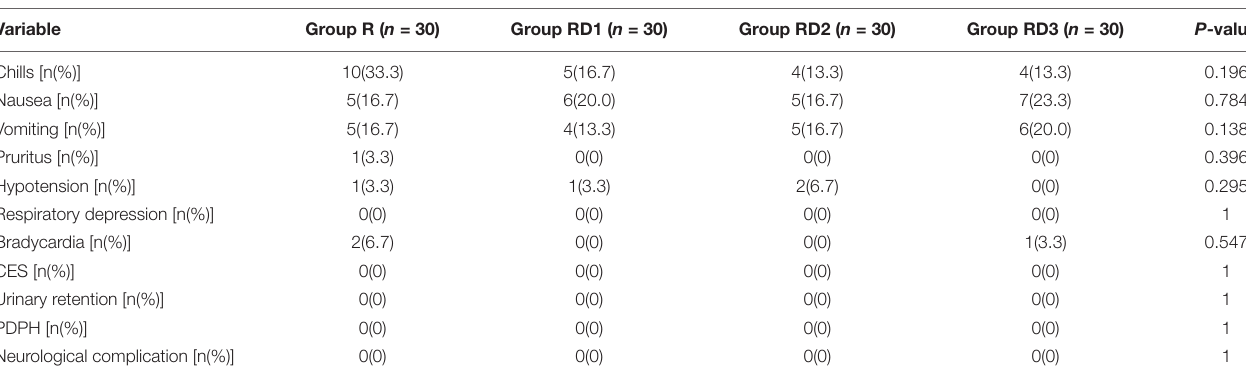
TABLE 4 | Adverse events within 24 h after surgery